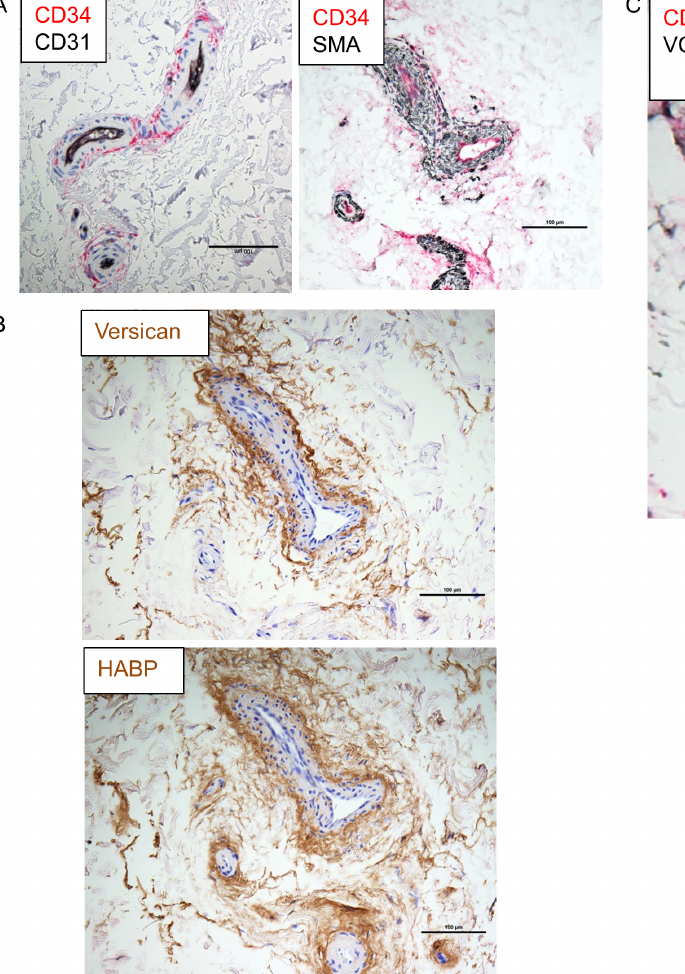
Fig 7. Immunostaining of the adventitial vasa vasorum. (A) The left panel shows an adventitial vessel in cross and tangential section stained for CD31 (black: endothelium) and CD34 (red: CD34 + progenitor cell and endothelium but the latter is masked by the black stain) and the right panel shows a cross and tangential section of a vessel stained for CD34 (red: CD34 + progenitor cell and endothelium) and SMA (black: pericytes). (B) Vessels stained for versican and hyaluronan (brown) in the top and bottom panels, respectively; and (C) a vessel stained for CD34 (red) and versican (black). The arrowhead indicates CD34 and versican co- localization compared to the arrow that indicates unlabeled pericytes. Scale bars indicate 100 μ m in A and B, and 50 μ m in C.